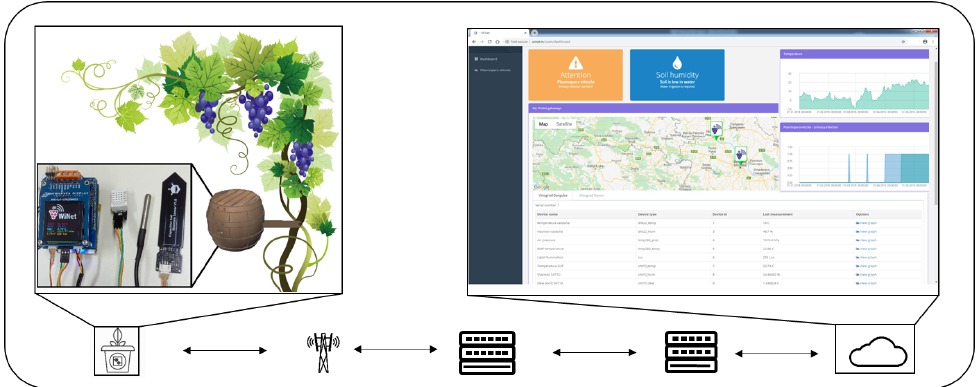
Figure 2. The Winet system overview focusing on hardware and software components: the barrel-like casing holds the NB-IoT module ( left ); Web user interface for vineyard mildew monitoring ( right